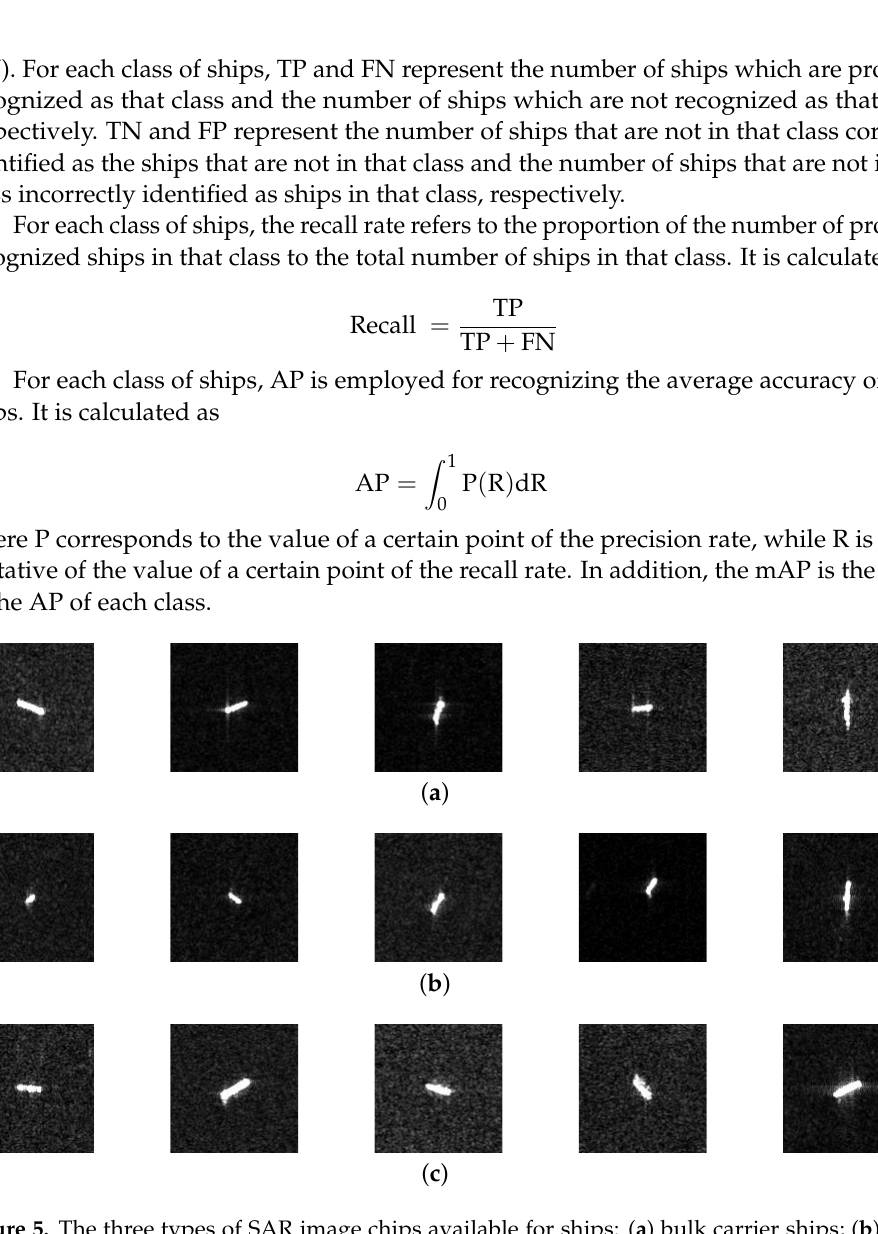
Figure 5. The three types of SAR image chips available for ships: ( a ) bulk carrier ships; ( b ) cargo ships; ( c ) container